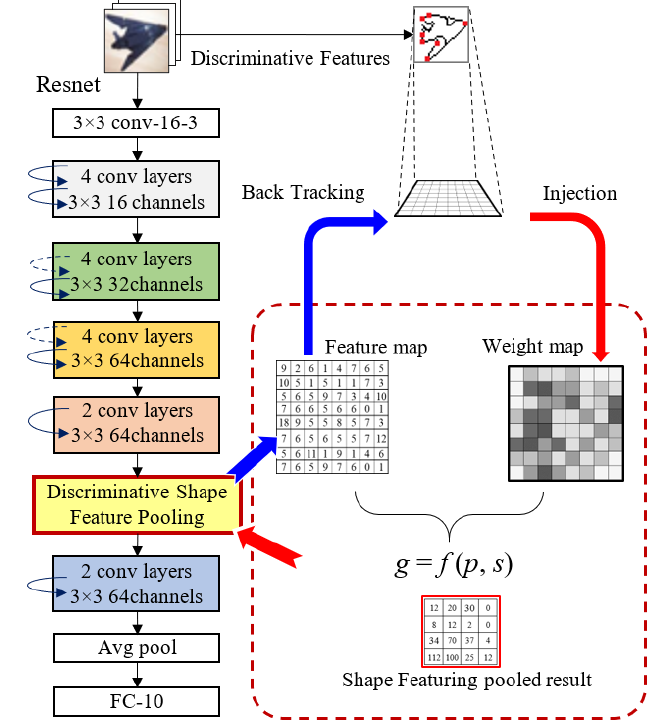
Figure 1. Architecture of DSF-Pooling in Resnet-18. Standard ResNet-18 only has the average pool right before the FC layer. Each convolutional block with curved arrows (skip connections) contains 6 convolutional layers. With the network hyperparameters, the feature map size is reduced from one block to another. The proposed DSF pooling layer is plugged into the networks (as shown in the yellow